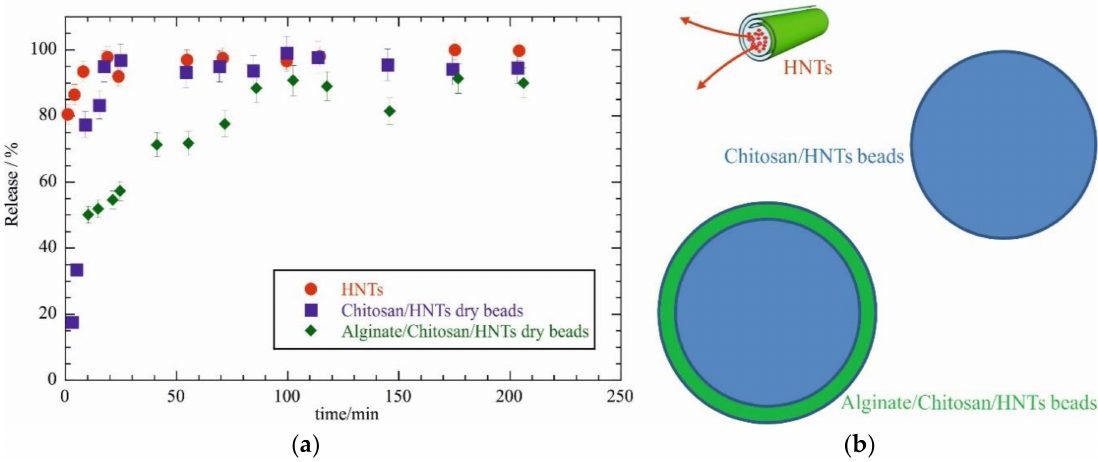
Figure 3. ( a ) Doxycycline chlorohydrate release as a function of time for different carriers. ( b ) Sketch view of the different release